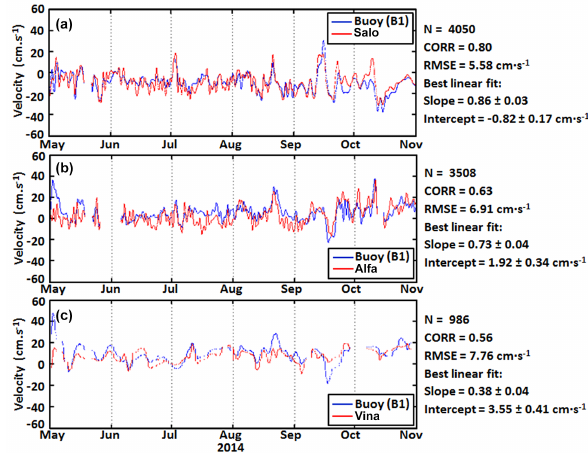
Figure 5. Comparison of low-pass filtered hourly time series (cut- off period of 30h) of radial currents measured by B1 buoy (blue line) and HF radar sites (red lines): (a) SALO, (b) ALFA and (c) VINA in the range arc point closest to the B1 location for a 6-month period May–October 2014, using calibrated antenna patterns. N , slope and intercept represent the number of hourly radial current observations and the results derived from the best linear fits, respec-